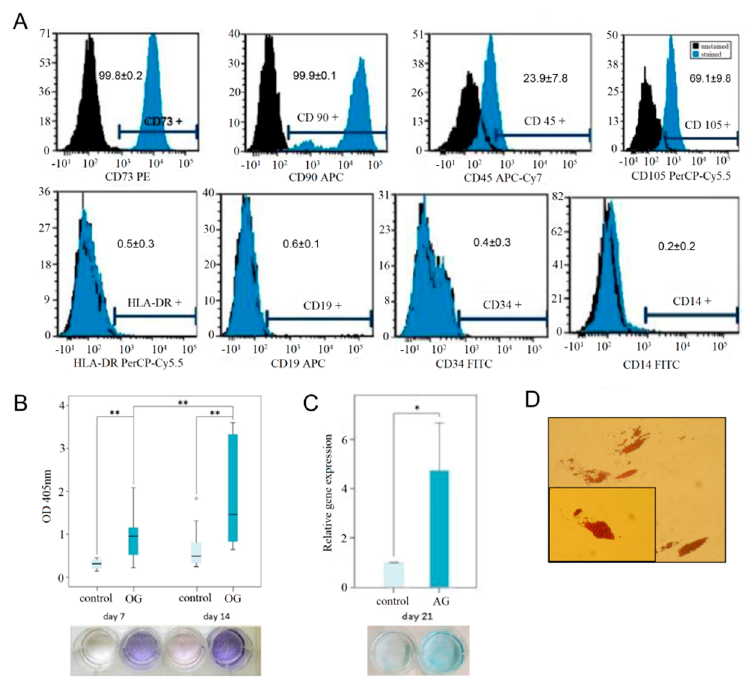
Figure 3. hMSPC characterization and multilineage di ff erentiation analysis. The used hMSPCs were characterized according ( A ) the positive expression of CD73, CD90, CD105, and negative expression CD14, CD19, CD34, CD45, and HLA-DR using multicolor fluorescence-activated cell sorting analyses. The values indicated the percentage of positively stained cells. The capacity for multilineage di ff erentiation potential was confirmed by ( B ) ALP staining for osteogenic di ff erentiation, ( C ) Alcian blue staining and the expression of aggrecan for the chondrogenic di ff erentiation, and ( D ) the Oil Red O staining of lipid droplets for the adipogenic lineage; p < 0.01 **; p < 0.05 *).